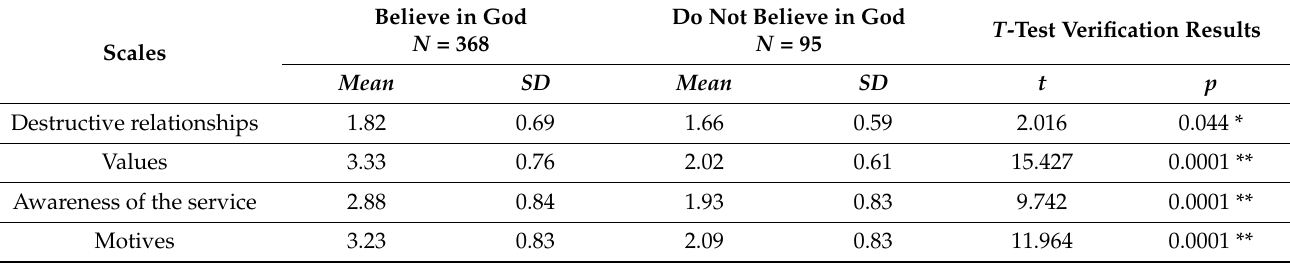
Table 2. The t -test verification by believing in